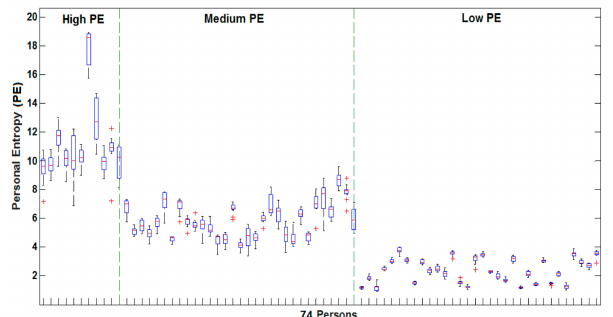
Figure 8. Boxplots of PE values for all 74 persons clustered into high, medium and low PE.